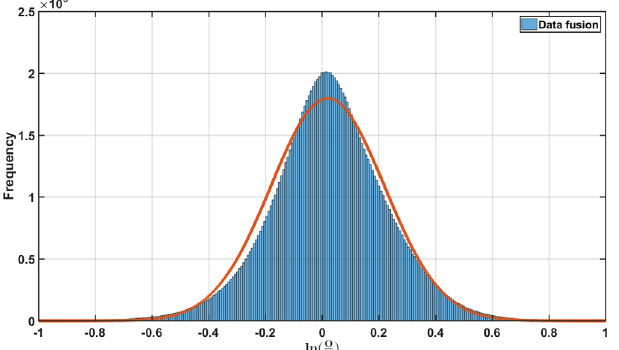
Fig. 3. (Left) Density ratios binned in latitude of DTM2020, (Right) density ratios binned in local solar time of DTM2020.